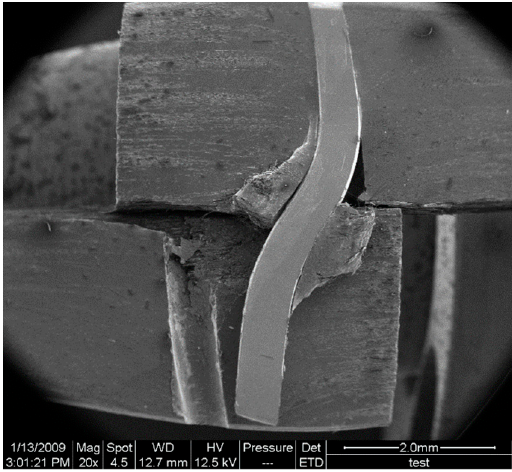
Figure 8. Morphology of the failed specimen for in situ observation.